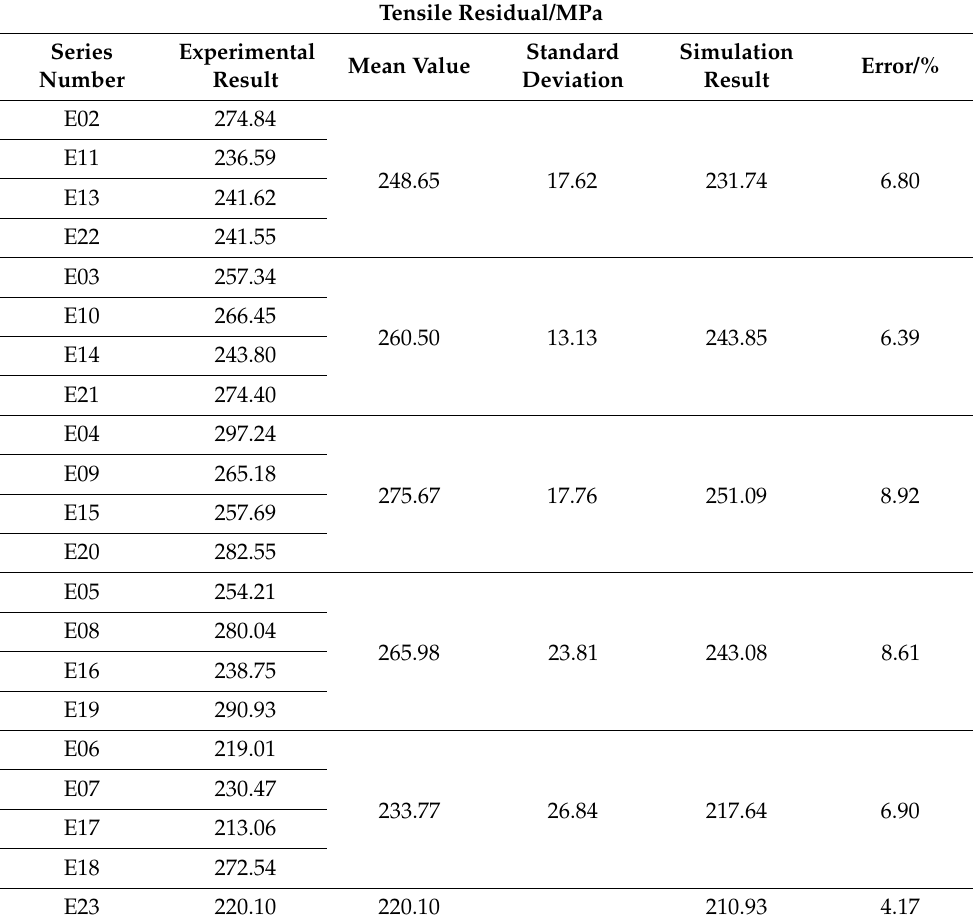
Table 4. Comparison between simulation and experimental